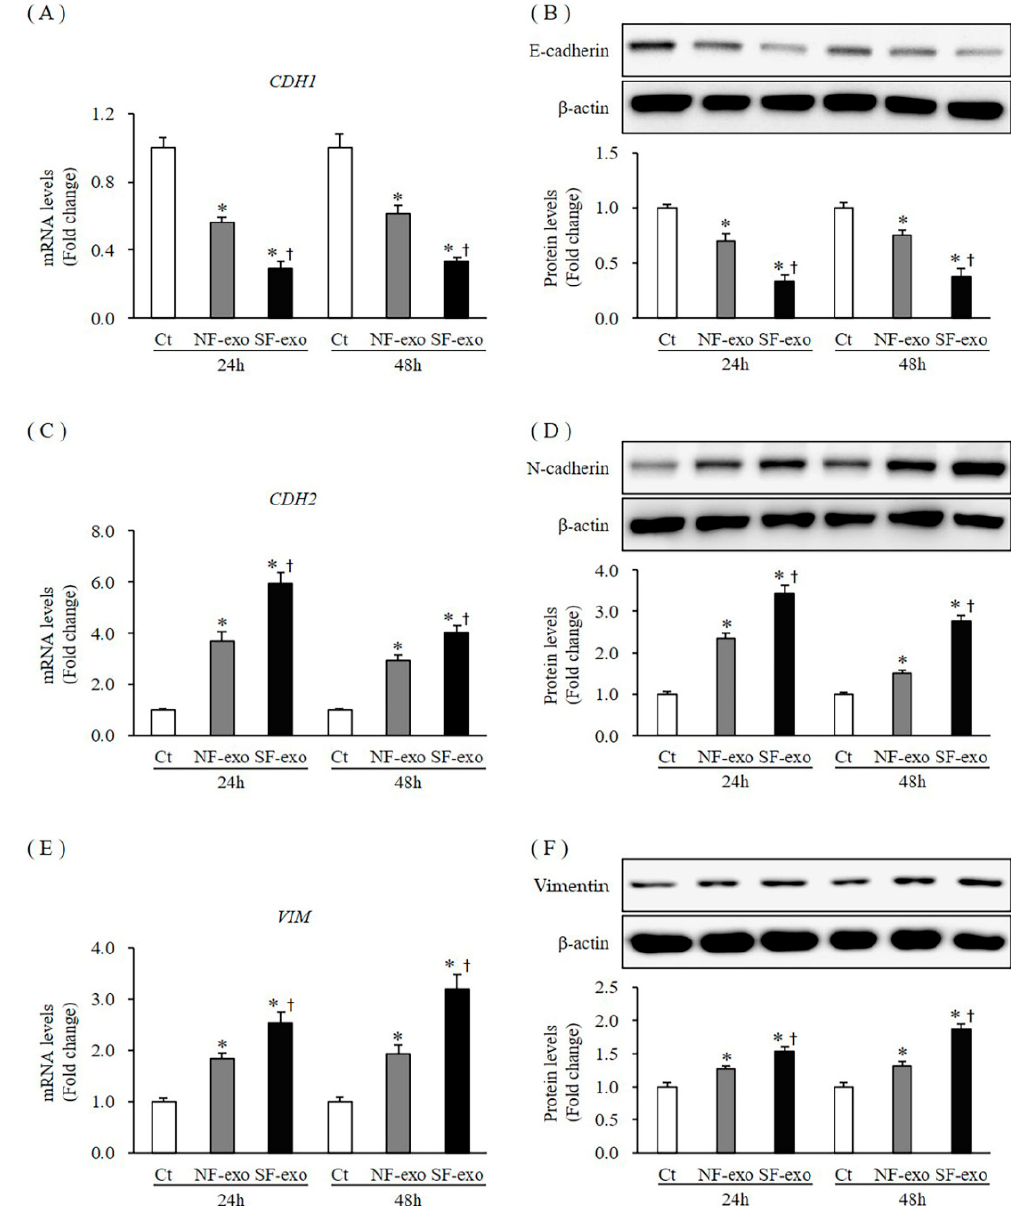
Figure 8. Expression of EMT markers in NHKs after NF- and HTSF-exosome treatment. The mRNA and protein expression of E-cadherin ( A , B ) in NHKs decreased significantly at 24 and 48 h after treatment with 100 µ g/mL NF-exosome, compared with that in the control cells. They further decreased with HTSF-exosome treatment compared with NF-exosome treatment at 24 and 48 h ( A , B ). The mRNA and protein expression of N-cadherin ( C , D ) and vimentin ( E , F ) increased significantly at 24 and 48 h after treatment with 100 µ g/mL NF-exosomes, compared with that in the control cells. They were further increased with HTSF-exosome treatment compared with NF-exosomes at 24 and 48 h ( C – F ). * p < 0.05 for NF- or HTSF-exosome-treated cells versus the corresponding matched control cells. † p < 0.05 for HTSF-exosome-treated cells versus NF-exosome-treated cells. Data represent the mean ± SD; n = 4. EMT, epithelial–mesenchymal transition; Ct, DPBS-treated control cells; NHK, normal human keratinocytes; NF, normal tissue-derived fibroblasts; HTSF, hypertrophic scar tissue-derived fi broblasts.